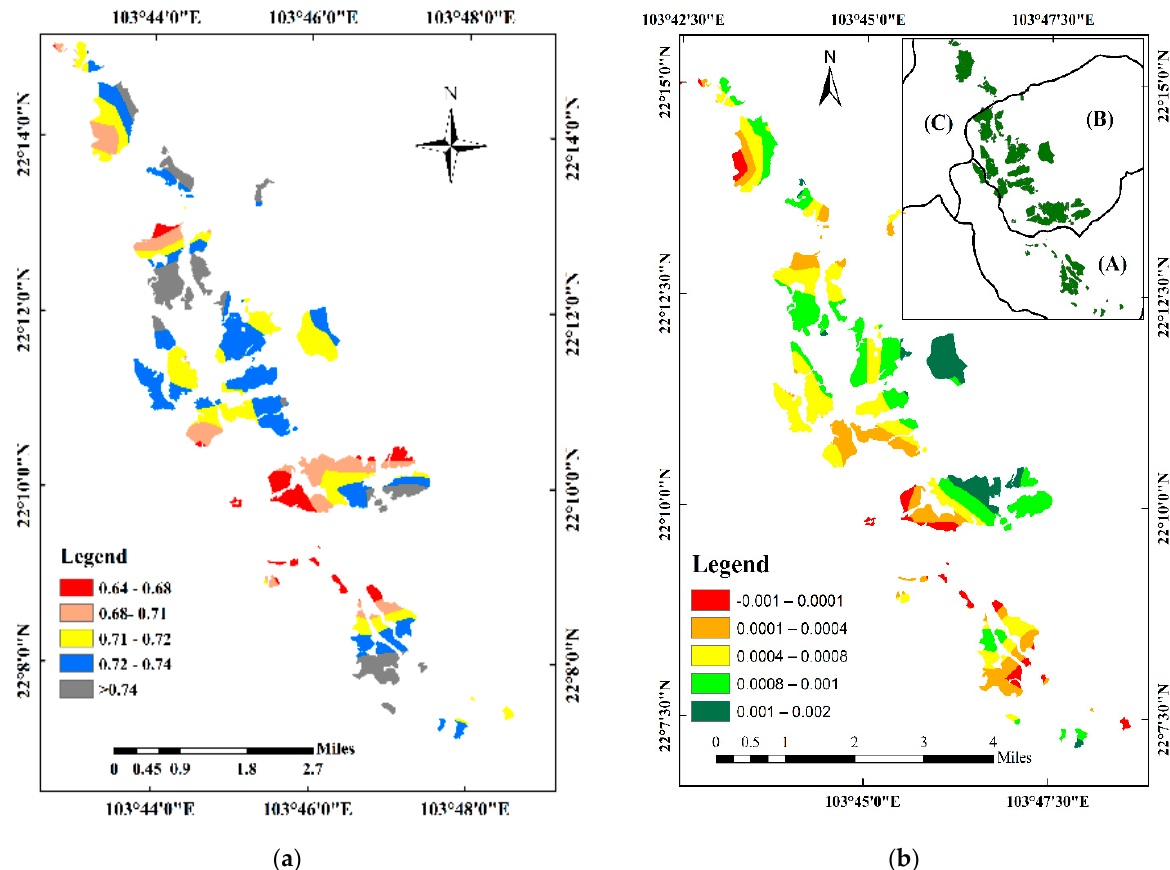
Figure 2. Spatial distribution of NDVI mean value ( a ); and NDVI trend ( b ) with (A) represent Trung Dong and Than Thuoc sub-area (TDTTSA), (B) represent the central sub-area (CSA), (C) represent Phuc Khoa sub-area (PKSA). Table 1. The trend of NDVI from 2009 to 2018.